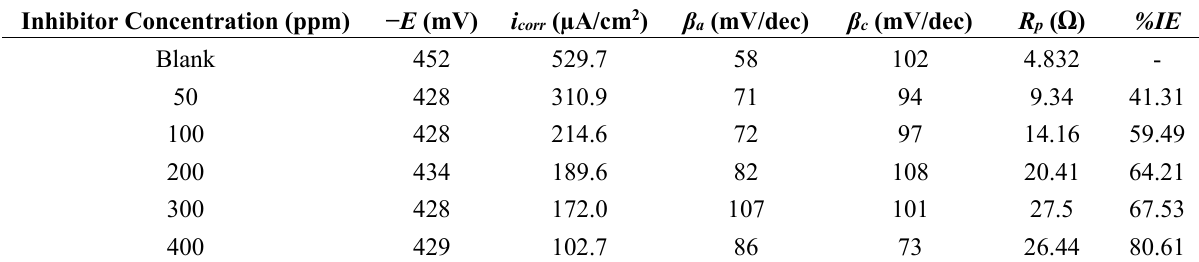
Figure 2. Polarization curves for the corrosion of mild steel in 1 M HCl with and without various concentrations of SB. Table 2. Electrochemical kinetic parameters from potentiodynamic polarization experiment. Inhibitor Concentration